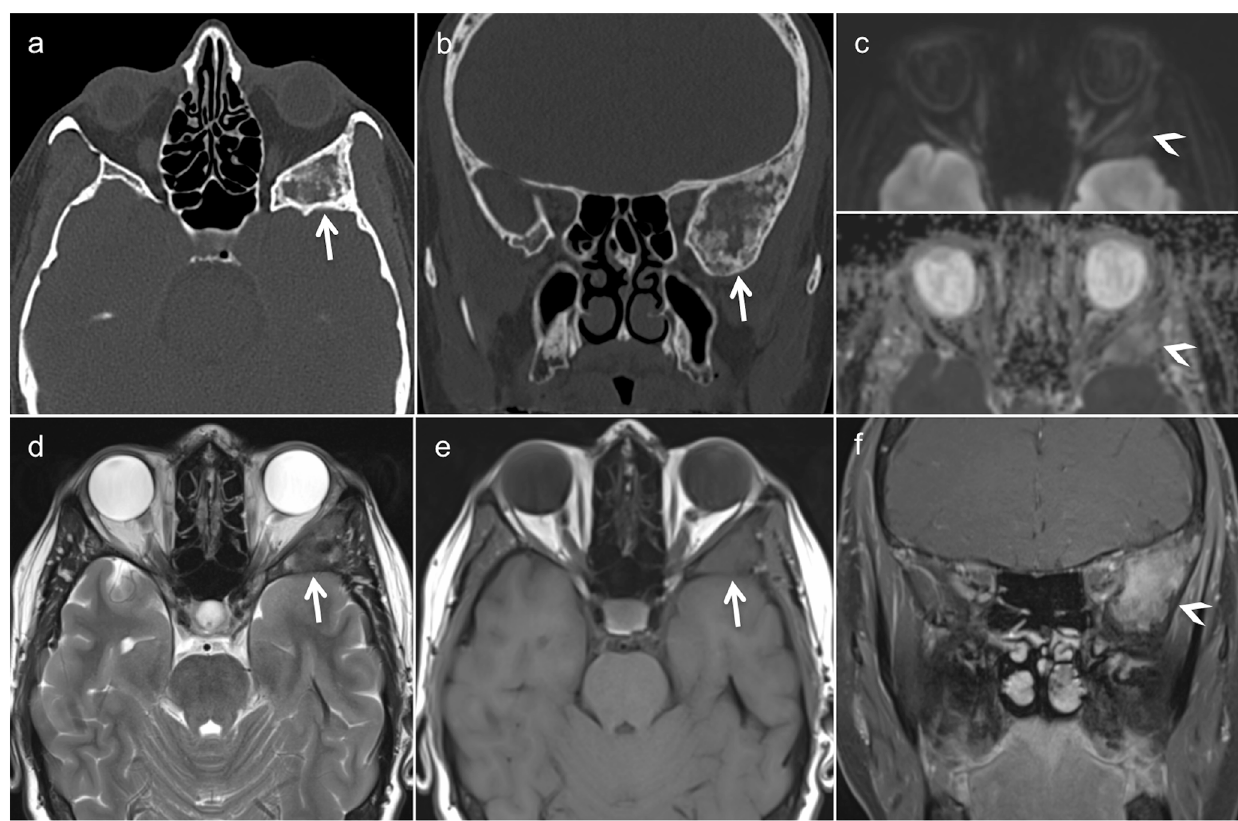
Fig. 2 Magnetic resonance imaging (MRI) findings of FD involving the greater wing of sphenoid bone in a patient with left orbital pain. Axial ( a ) and coronal( b ) CTimages (bonewindow) show an enlarged greater wing of the left sphenoid bone ( arrows ) with medullary expansion and intact cortical outline. Ground-glass opacities within the affected bone. No bone destruction. c Diffusion-weighted imaging ((DWI) reveals intermediate